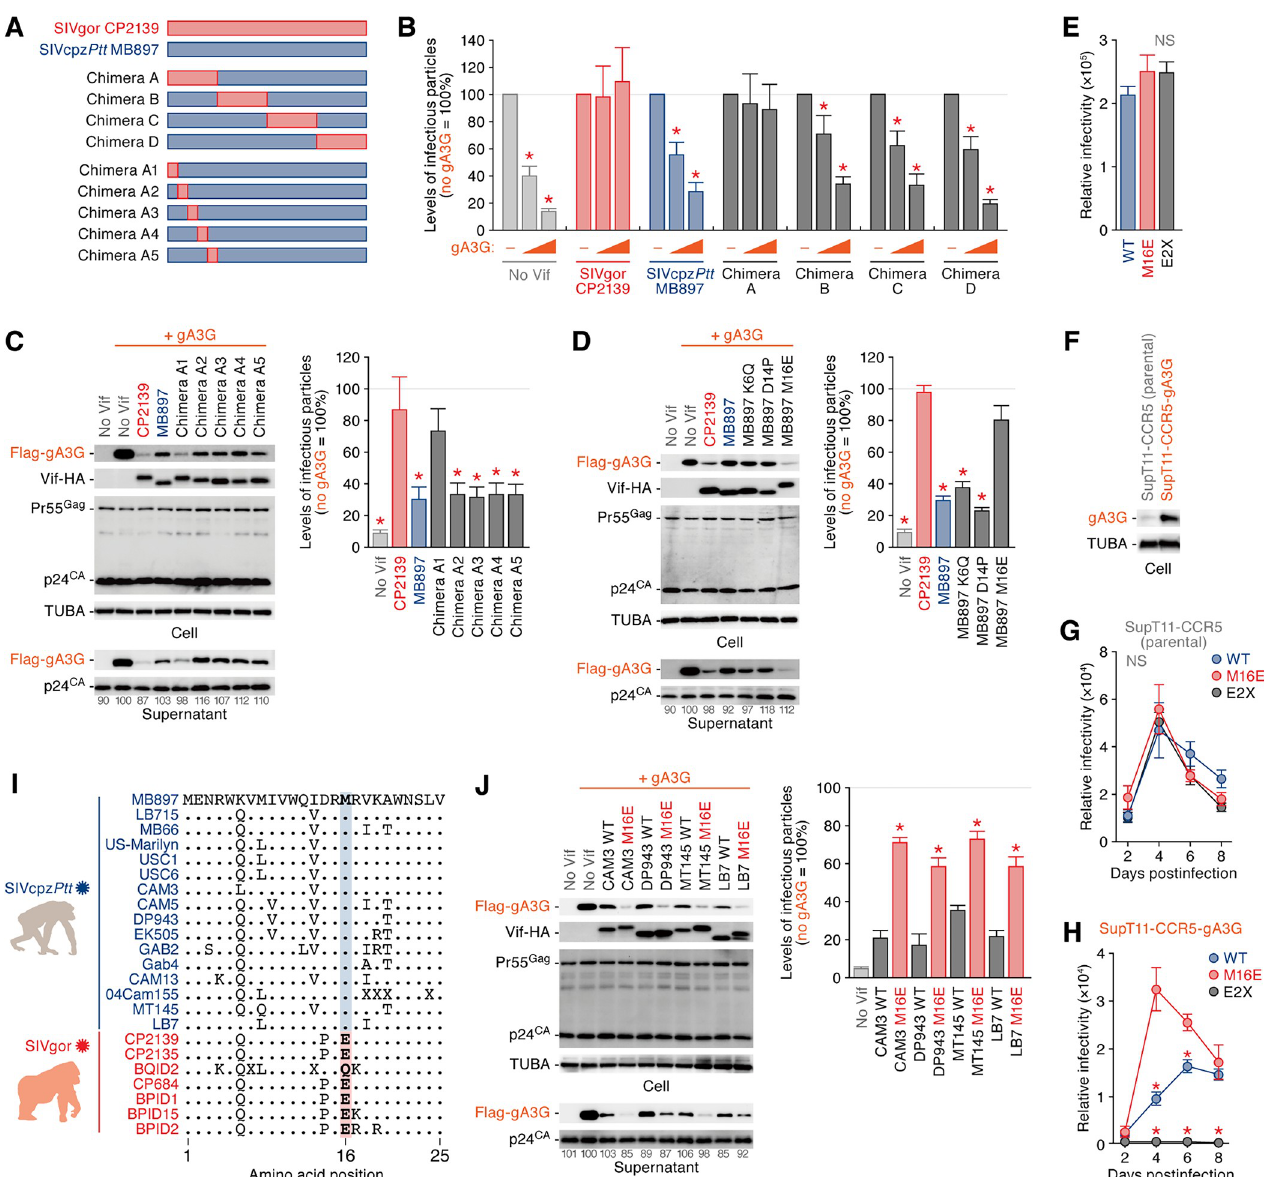
Fig 2. Gain-of-function experiments of SIVcpz Ptt Vif to counteract gA3G. (A) A scheme of SIVcpz Ptt MB897 Vif derivatives used in this study. (B-D) Determination of the amino acid residue of SIV Vif that is responsible to neutralize gA3G. HEK293T cells were co-transfected with pNL4-3 Δ vif (500 ng) and the expression plasmids for gA3G (10 or 50 ng; the plasmid amount was normalized by empty vector) and the indicated Vif derivatives (500 ng). (E) Infectivity of the infectious viruses of SIVcpz Ptt MB897 WT, M16E and E2X ( vif deleted) derivatives. These viruses were prepared as described in Materials and Methods and the infectivity was measured by using TZM-bl cells. The mean values of three independent experiments ± SEM are shown. (F-H) (F) Expression of gA3G in SupT11-CCR5 cells. The SupT11-CCR5 cells stably expressing gA3G (SupT11-CCR5-gA3G) was prepared as described in Materials and Methods. For Western blotting, the input of cell lysate was standardized to TUBA, and representative results are shown. (G and H) Multi-round replication assay of SIVcpz Ptt . The infectious viruses of SIVcpz Ptt MB897 WT, M16E and E2X ( vif -deleted) derivatives were inoculated into parental SupT11-CCR5 cells (G) or the SupT11-CCR5-gA3G (H) at MOI 0.1. (Left) Culture supernatant was routinely harvested and the amount of infectious viruses was measured by using TZM-bl cells. (I) Conservation of residue 16 in the Vif proteins of all SIVcpz Ptt and SIVgor strains reported. Note that “X” is an undefined amino acid because of nucleotide ambiguity. (J) Importance of M16E substitution in other SIVcpz Ptt strains to counteract gA3G. HEK293T cells were co-transfected with pNL4- 3 Δ vif (500 ng) and the expression plasmids for gA3G (50 ng) and the indicated Vif strains and derivatives (500 ng). In B-D and J, cells and supernatants were harvested at two days post-transfection and were used for Western blotting and TZM-bl assay. For Western blotting, the input of cell lysate was standardized to TUBA, and representative results are shown. The band intensity of viral p24 was quantified and the intensity value of the gA3G expressing cells without Vif (second from the left) was set to 100%. For TZM-bl assay, the percentage of the value without gA3G is shown. The mean values of nine independent experiments ± SEM are shown. Statistically significant differences ( P < 0.05) versus “CP2139” (B-D), “M16E” (G and H) or “WT” (J) are shown by red asterisks. NS, no statistical